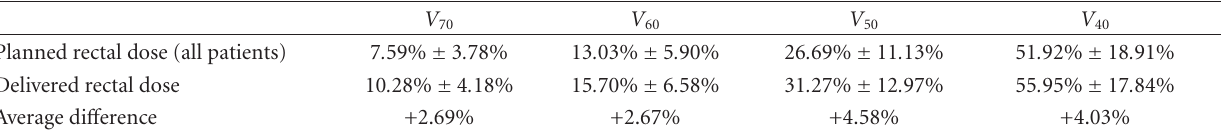
Table 3: Detailed volumetric results of daily retrospective dosimetry